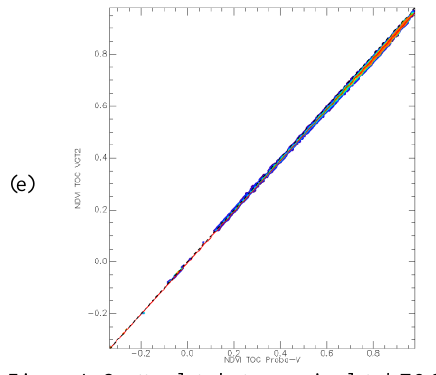
Figure 4. Scatterplots between simulated TOC reflectances of PROBA-V and VGT-2 for (a) Blue; (b) Red; (c) NIR; (d) SWIR; (e) NDVI All results except the SWIR band results show comparable RMSE and agreement coefficients..For SWIR, the TOC correction shows better RMSE and agreement than the TOA correction. Interestingly, for all reflectance band results the slope correction values show the opposite trend from those found for the TOA datasets, particularly for the SWIR band. Only the NDVI results shows a similar trend in its TOA and TOC correction